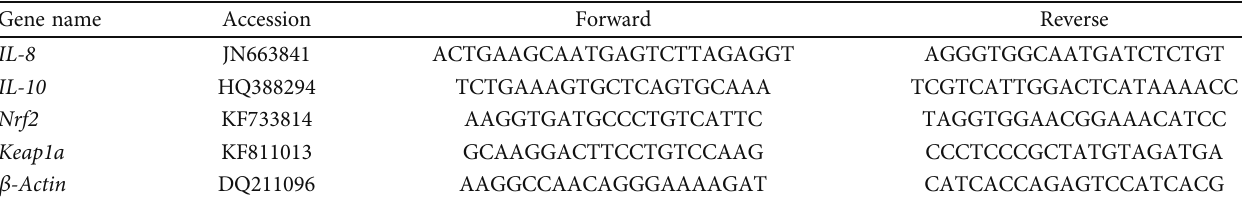
Table 3: The primers for qPCR.